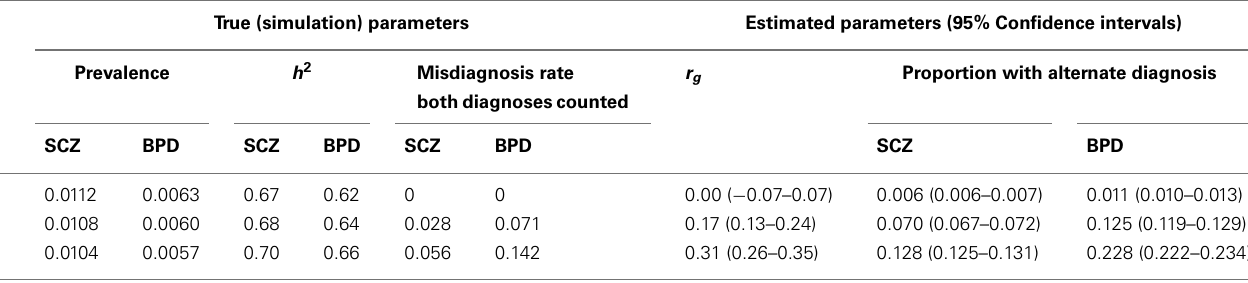
Table 3 | Simulation results: simulation parameters were selected to generate estimated diagnosis prevalence rates and heritabilities that match empirical estimates for schizophrenia (SCZ) and bipolar disorder